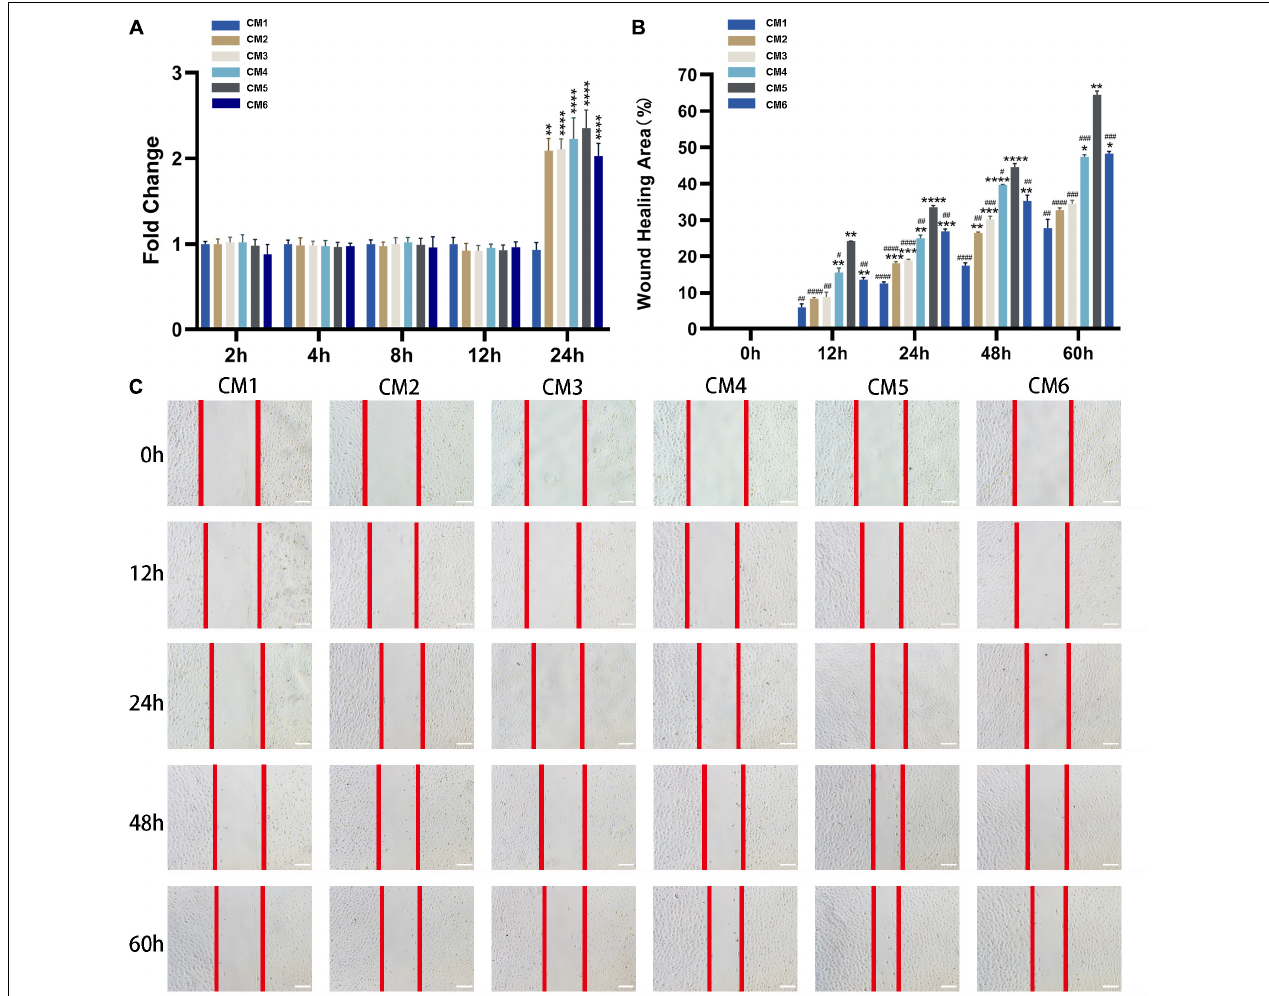
FIGURE 3 | CM promotes the viability and migration of tendon fibroblasts. (A) Cell viability was evaluated with CCK-8. CM treatment had no effect on the viability of tendon fibroblasts at 2, 4, 8, and 12 h, but the viability was doubled at 24 h. The effect was independent of HGF concentration. (B,C) The migration of tendon fibroblasts was evaluated with the wound healing assay. Red lines indicate the migration front. The wound closure of the fibroblasts with CM1-5 increased gradually. The maximum rate of migration was observed with CM5. No further increase of wound closure was observed with CM6. Bars: 200 µ m. *, versus CM1. * means p < 0.05, ** means p < 0.01, *** means p < 0.001, **** means p < 0.0001. #, versus CM5. # means p < 0.05, ## means p < 0.01, ### means p < 0.001, #### means p < 0.0001.